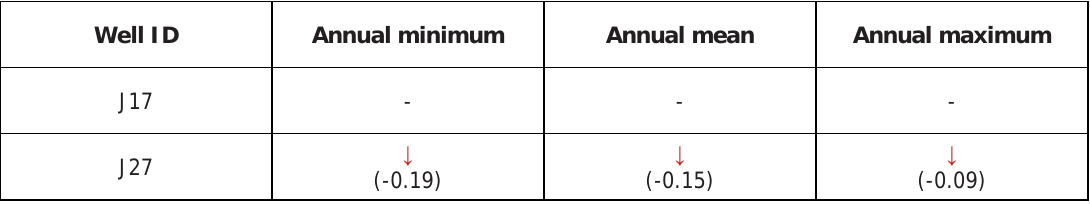
Table S1. Summary of trends and changepoints in annual minimum, mean, and maximum of daily-high water levels at wells J17 and J27 (significance assessed at p≤0.05). Sen slope values are shown in parentheses.